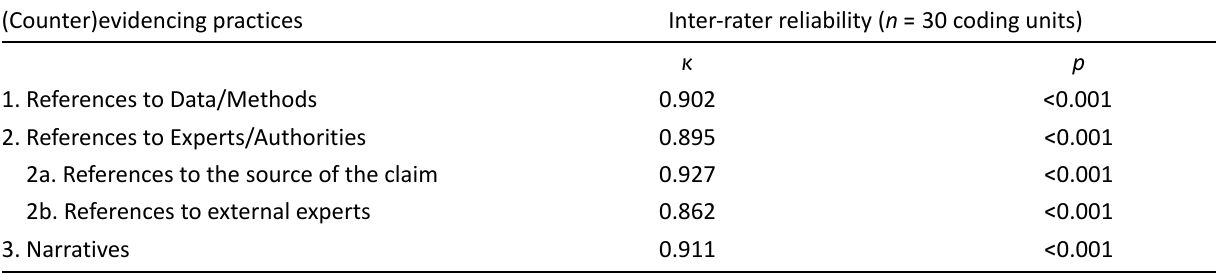
Table 1. Inter‐rater reliability in identifying (counter)evidencing practices (Cohen’s 𝜅 ). (Counter)evidencing practices